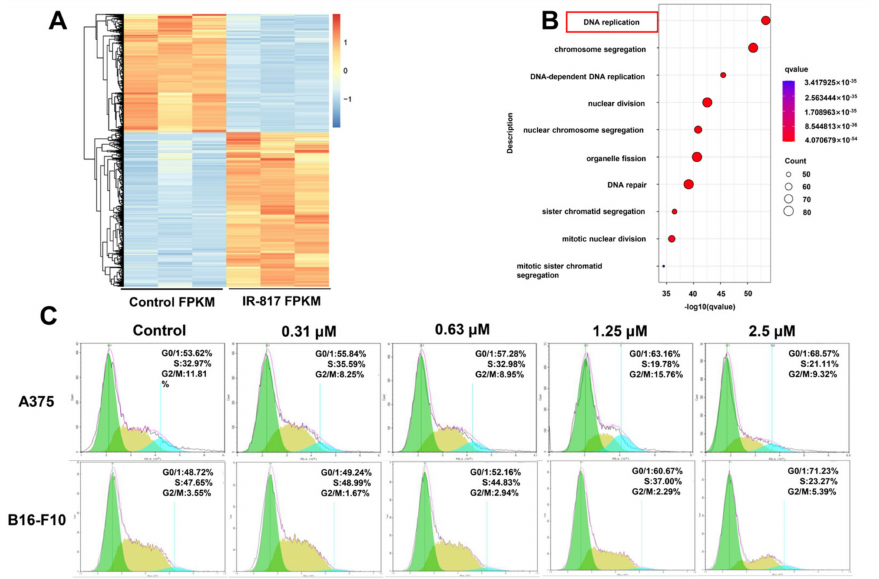
Figure 5. IR-817 induces melanoma cell cycle arrest in G0/G1 phase. ( A ) Heat map of differentially expressed genes in B16-F10 cells treated with IR-817 for 24 h compared with the control group. ( B ) KEGG pathways enriched from downregulated genes. The X-axis represents the number of target symbols for each pathway, while the Y-axis represents the main pathways ( p < 0.01). ( C ) The cell cycle distribution of A375 and B16-F10 cells treated with different concentrations of IR-817 for 24 h were identified by flow